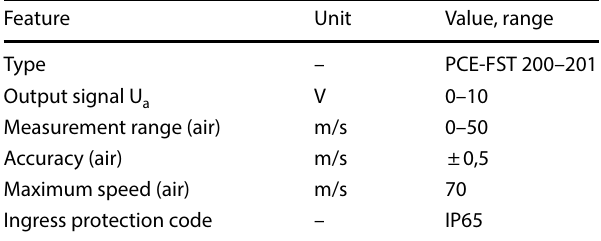
Table 1 Essential specifications of the anemometer [22]